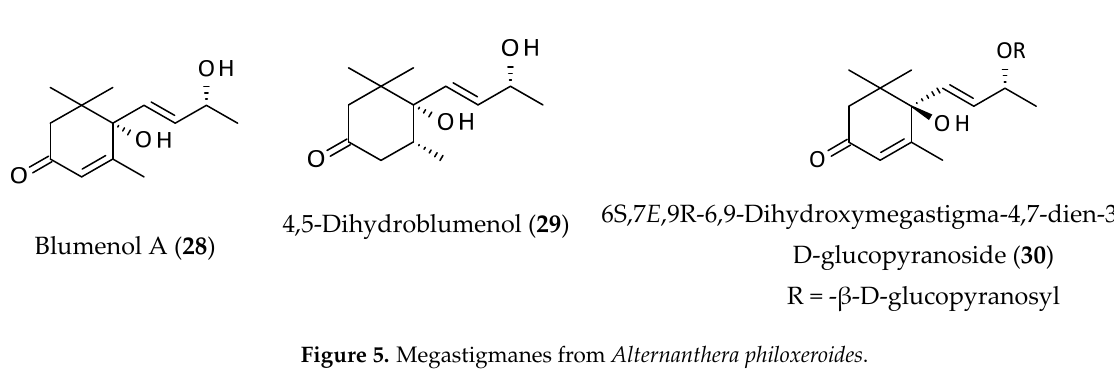
Figure 5. Megastigmanes from Alternanthera philoxeroides .